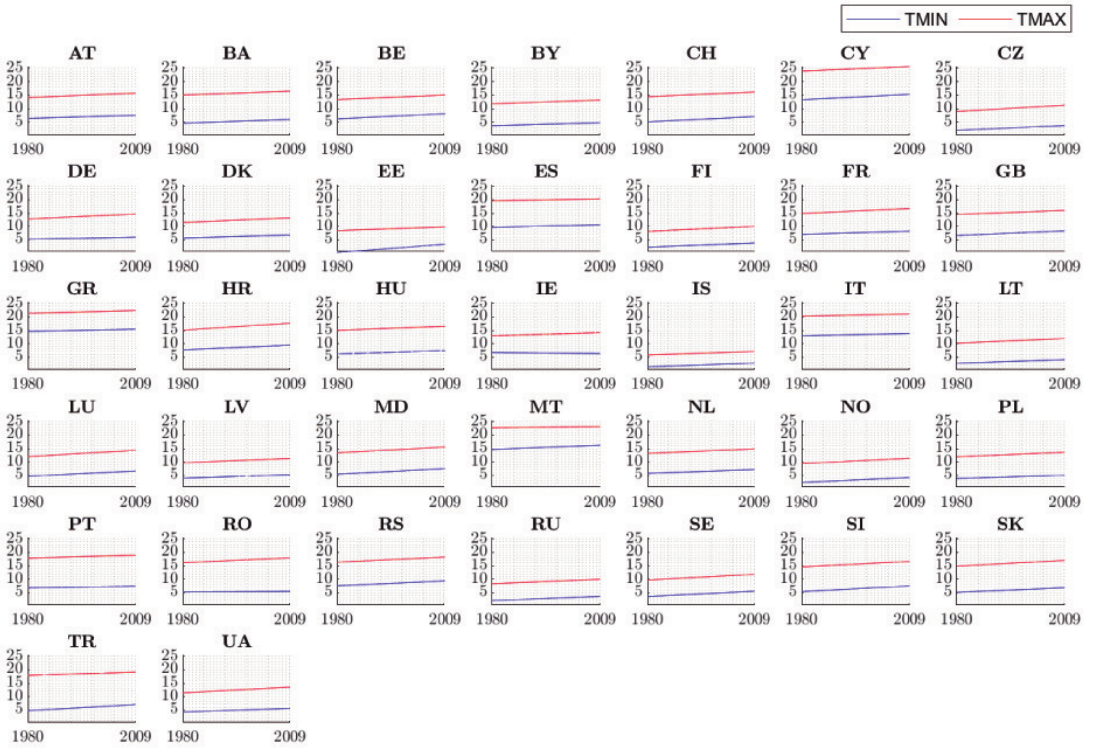
Figure A2. Trend component obtained with the GAM model for the 37 reference European weather stations and the minimum and maximum temperatures.